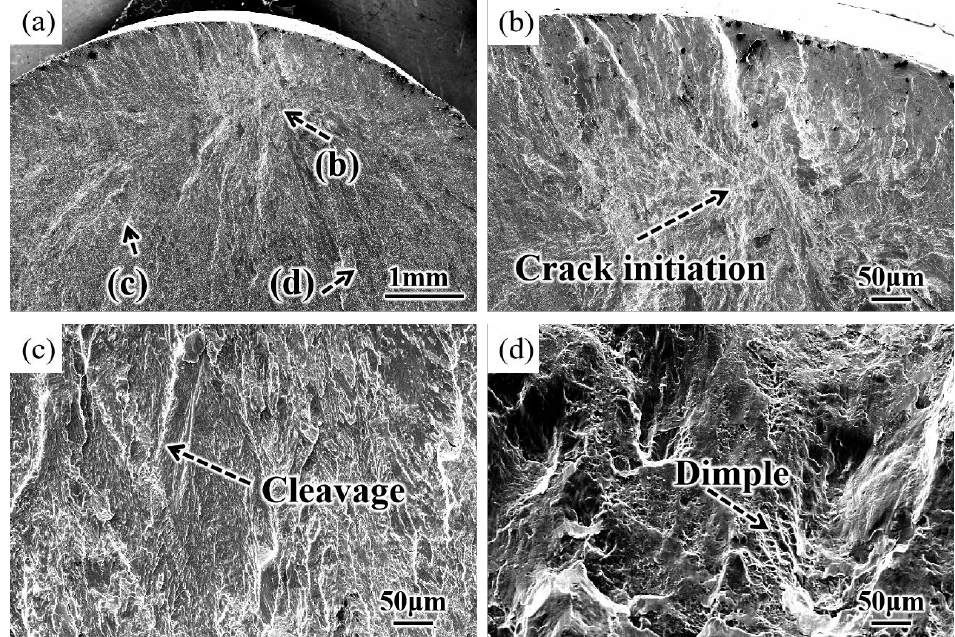
Figure 14. Fracture morphology of SUR2 sample. ( a ) Low multiplier, ( b ) crack source region, ( c ) crack propagation region, ( d ) fracture region.